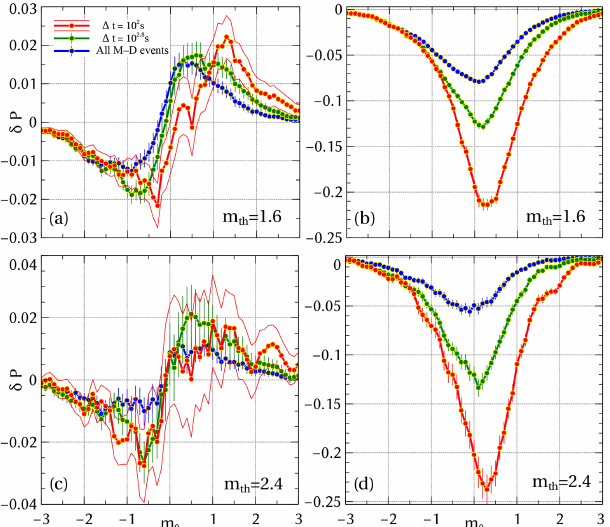
Figure 5. Magnitude correlations for the SSAR-SC catalog with (cid:49)t conditioning for sub-catalog randomizing (a, c) and full-catalog randomizing (b, d) for m th = 1 . 60 and 2.40. To see the trends clearly, only 1 σ error bars are shown.